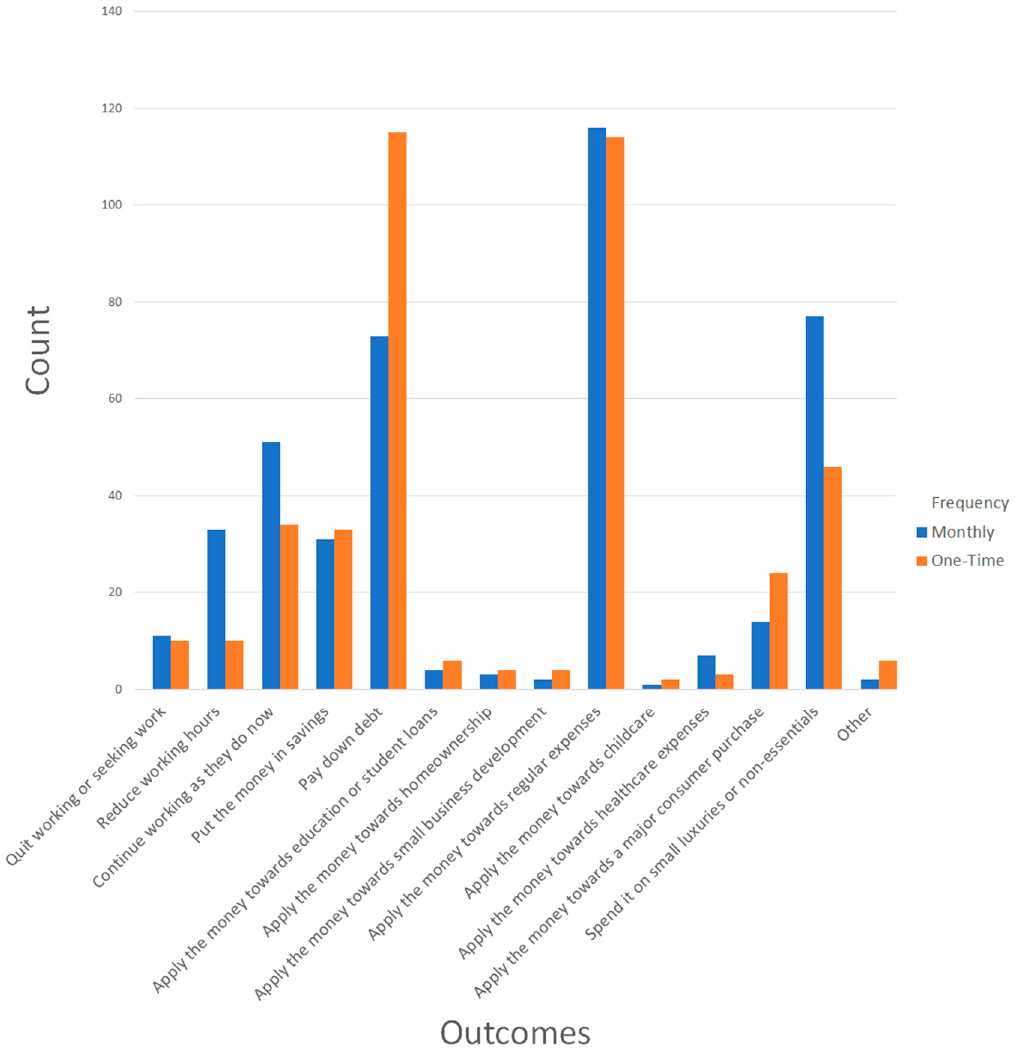
Figure 1. Perceived outcomes of receiving basic income benefits by payment frequency (monthly vs. one ‐ time).